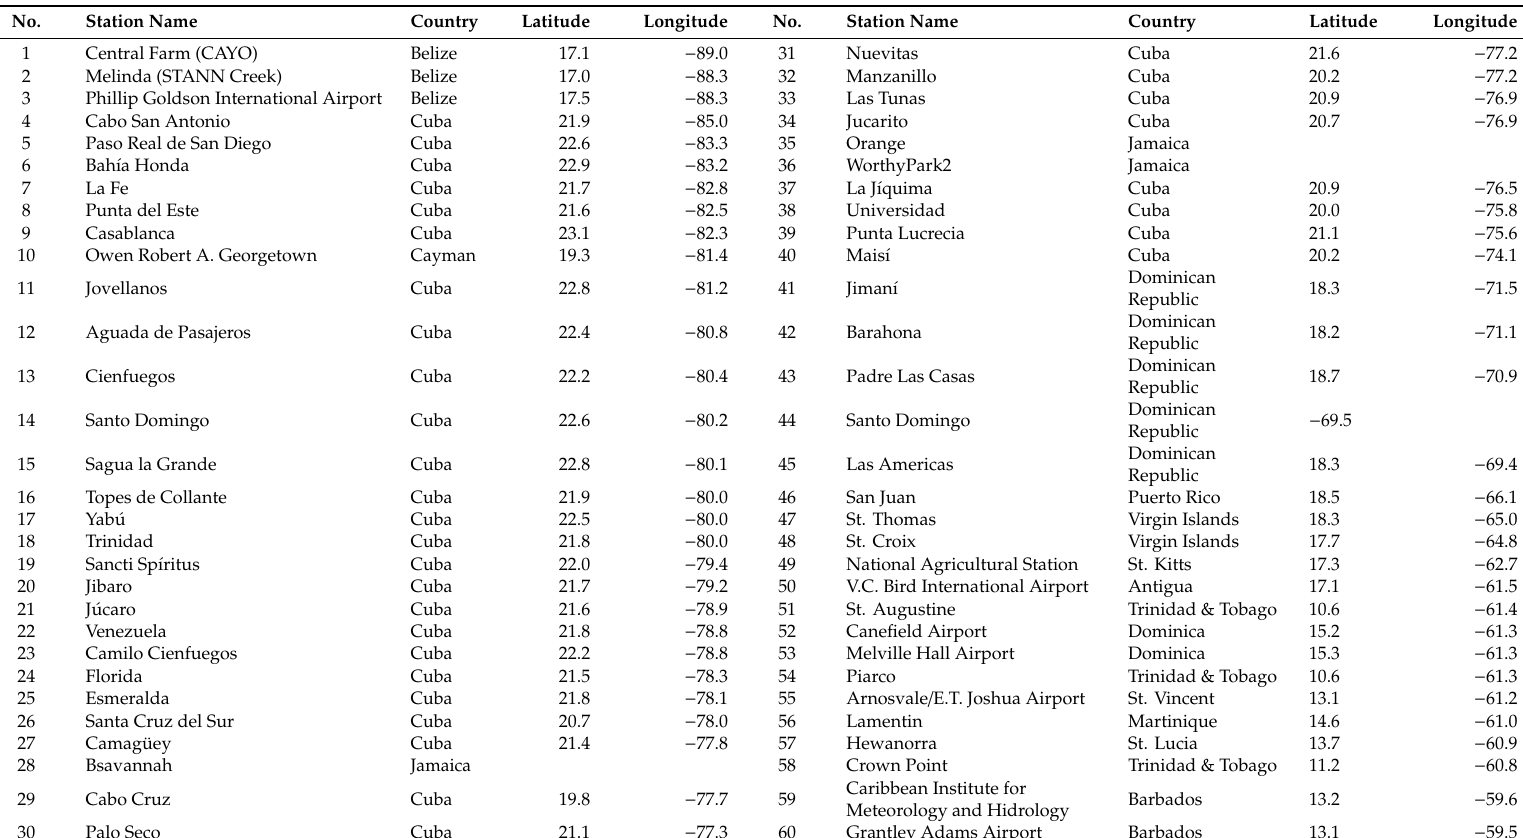
Table A1. Rain-gauges used in the study. The stations are organized from the western to the eastern Caribbean.